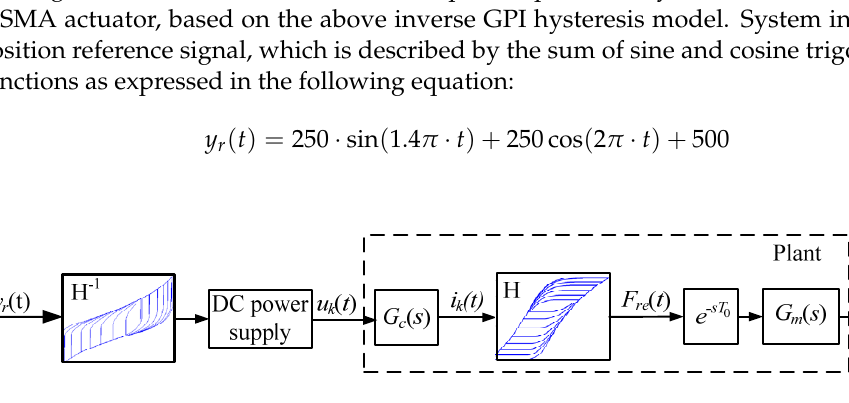
Figure 16. Block diagram of open-loop control system.